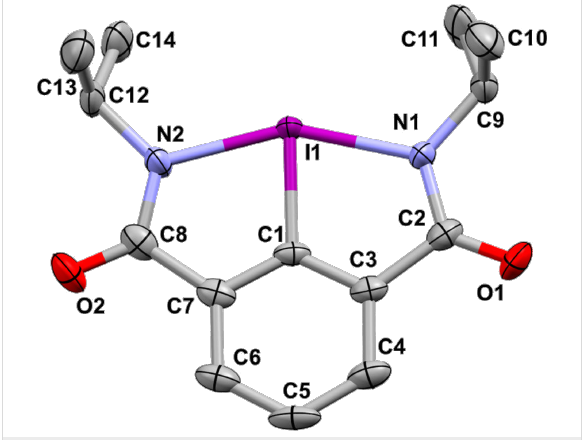
Figure 1: X-ray crystal structure of compound 7a . Ellipsoids are drawn to the 50% probability level. Selected bond lengths and angles: I(1)–C(1) 2.040 (4) Å; I(1)–N(1) 2.184 (4) Å; I(1)–N(1) 2.177 (4) Å; N(1)–I(1)–C(1) 76.89 (18)°; N(2)–I(1)–C(1) 77.02 (18)°; N(1)–I(1)–N(2) 153.90